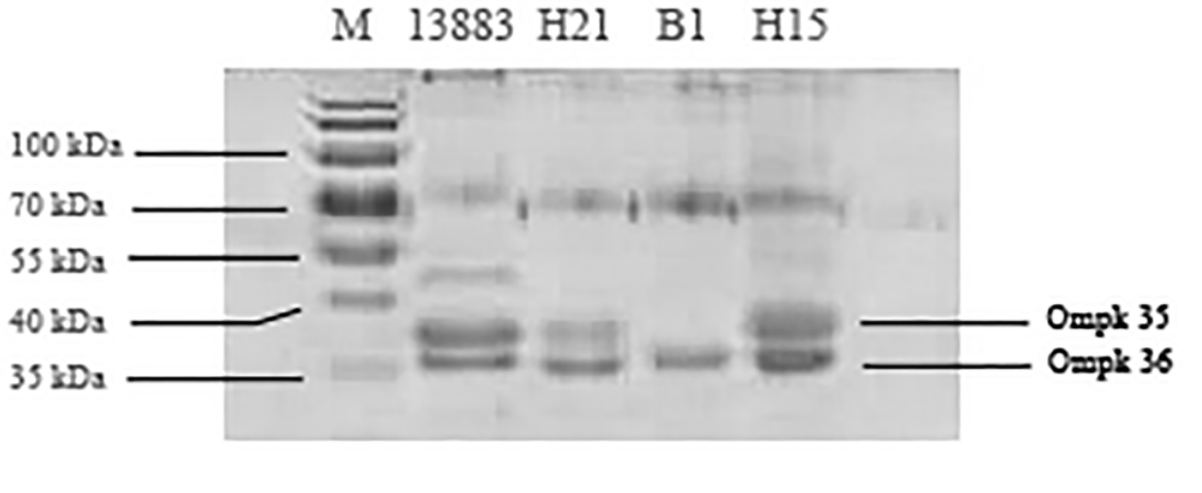
Fig 1. SDS-PAGE of outer membrane proteins. M: Marker; 13883: ATCC13883; B1: strain with OmpK36